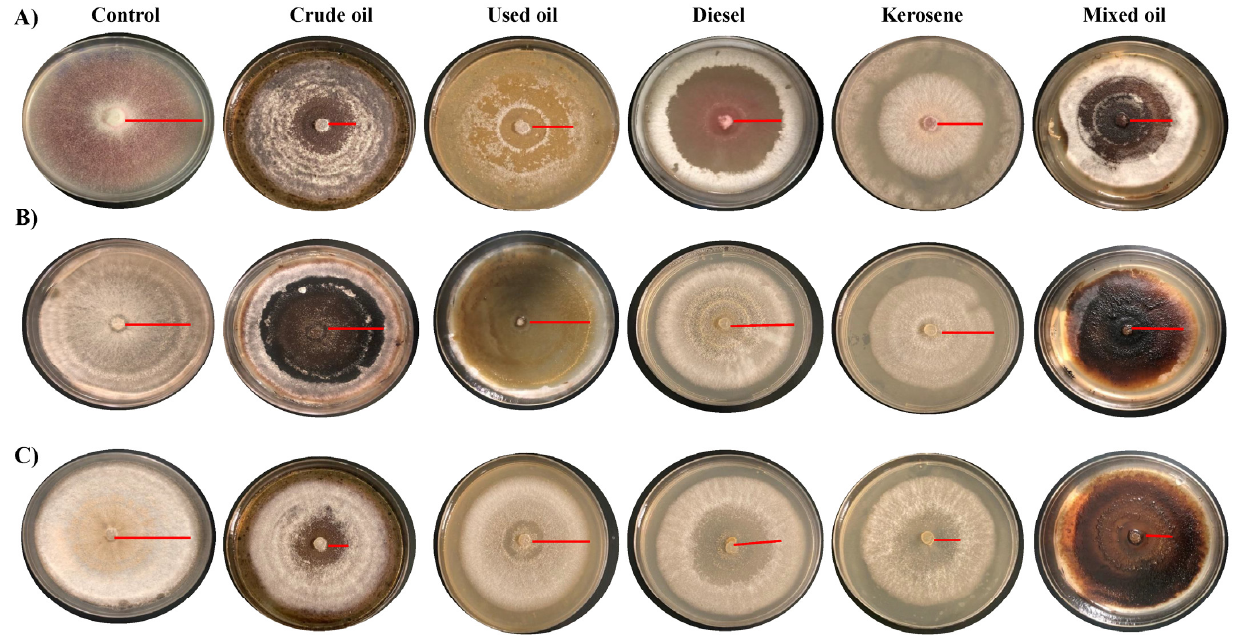
Figure 1. Fungal growth in solid MSM media with different carbon sources. Isolated species were cultured in Petri dishes containing Mineral Salt Medium (MSM) agar supplemented with 1% ( v / v ) of different hydrocarbons and incubated for a week. Red lines indicated the growth area of each species from borders to the dish center. ( A ) F. verticillioides , ( B ) F. proliferatum ( C ) F. oxysporum .